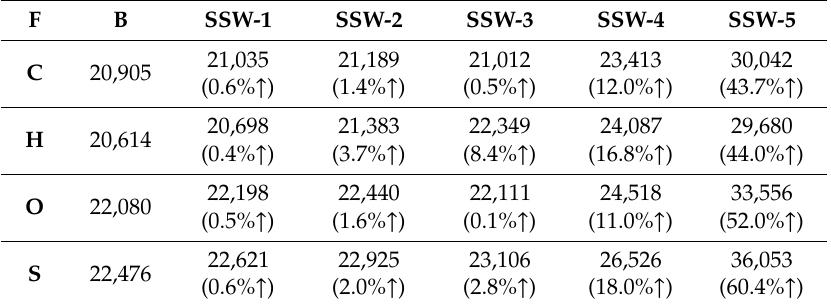
Table A1. Travel distance from residents in Cathedral Parish to